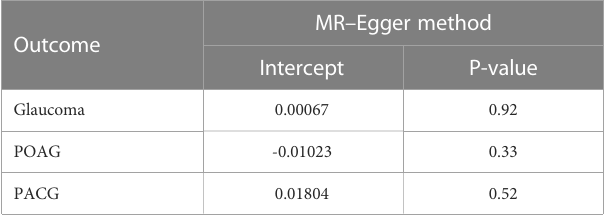
TABLE 2 MR – Egger pleiotropy